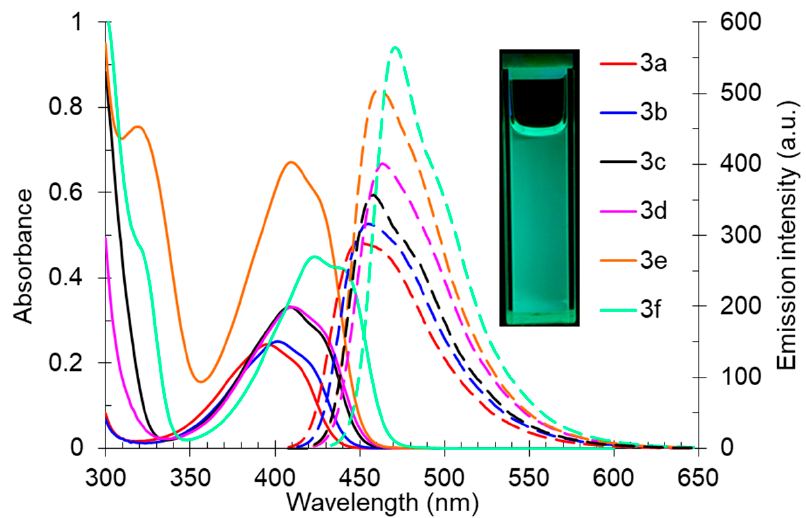
Figure 5. UV-vis absorption (5 × 10 − 5 M, solid lines) and emission (5 × 10 − 5 M, dashed lines) spectra of compound 3 in toluene. A photo of solution 3f in toluene was taken under 365 nm of irradiation.